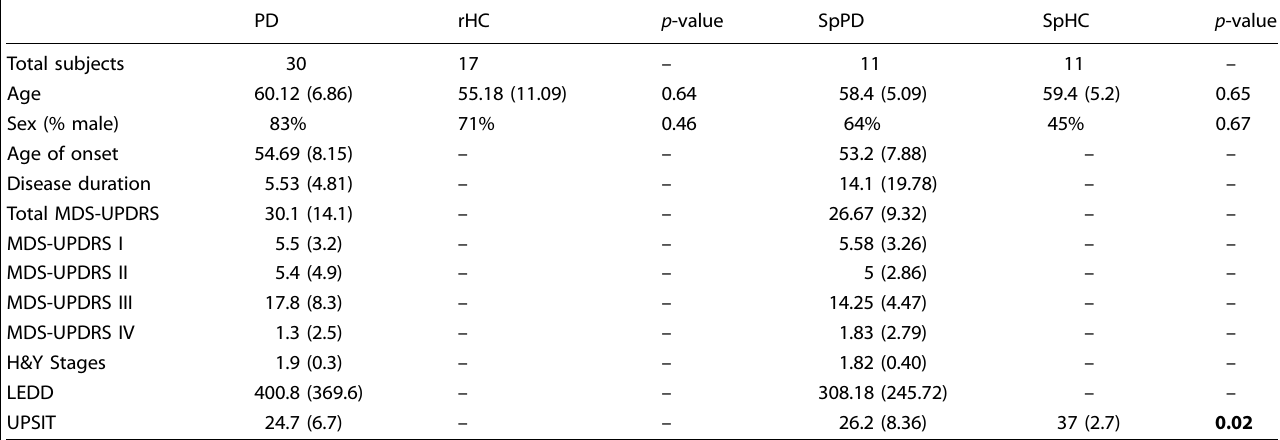
Table 2. Clinical features of Parkinson ’ s disease subjects and healthy control